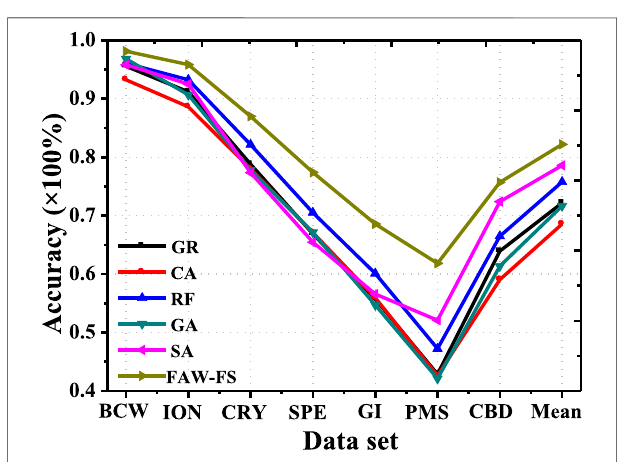
FIGURE 7 | Analysis on accuracy based on meta heuristic algorithm under the feature of RF.